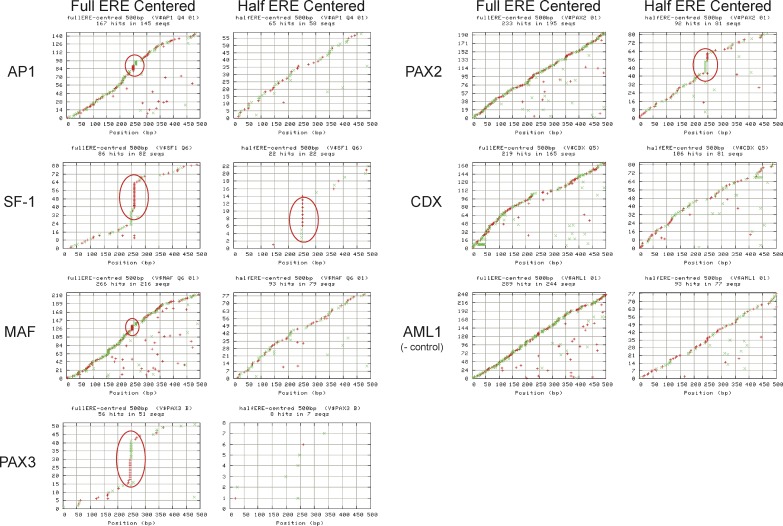
Nonrandom Positional Distribution of AP-1, SF1, MAF, PAX3, PAX2, CDX, and AML1 (as Negative Control) Binding Sites in the 500-bp Window Centered on the Main EREThe y-axis represents the cumulative frequency of the specific transcription factor motif, and the x-axis represents the position of that motif relative to the ERE centered at position 250. Motif hits are marked in red “+” and green “X” indicating forward and reverse strand hits respectively. Multiple hits on the same sequence are depicted as multiple marks on the same y-value sequence.